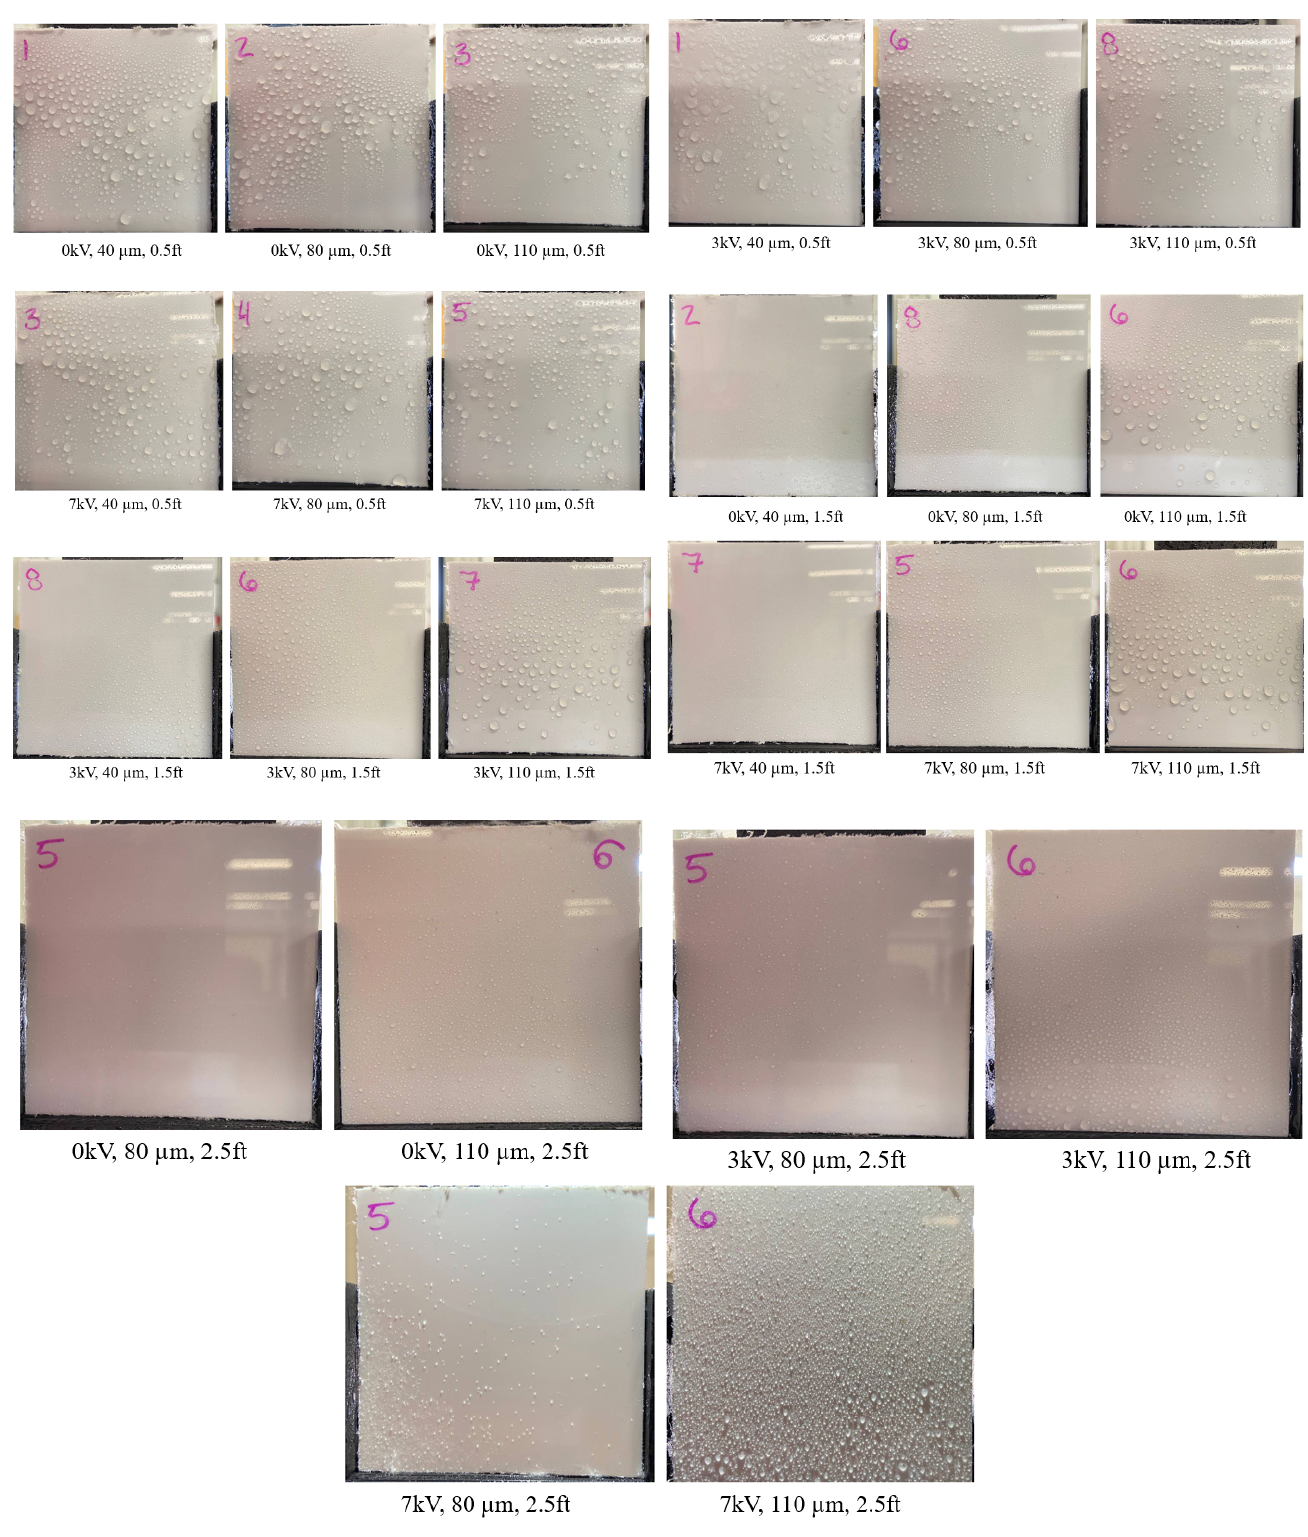
Figure A23. PVC: qualitative images of electrostatic deposition under various system